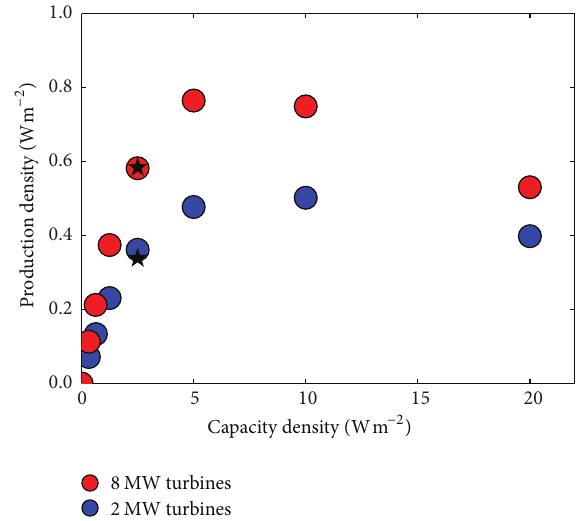
Figure 7: As in Figure 8, but average wind farm capacity factor CF for various deployments. Figure 8: Average wind farm production density PD for various